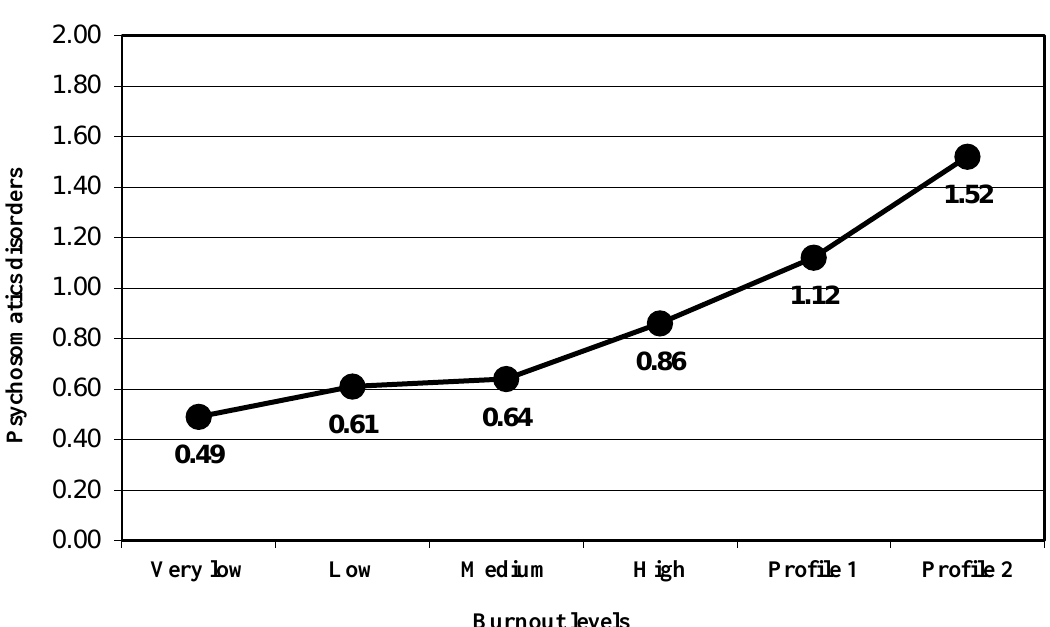
Figure 3. Mean in the alcohol intake variable for the groups of burnout levels.